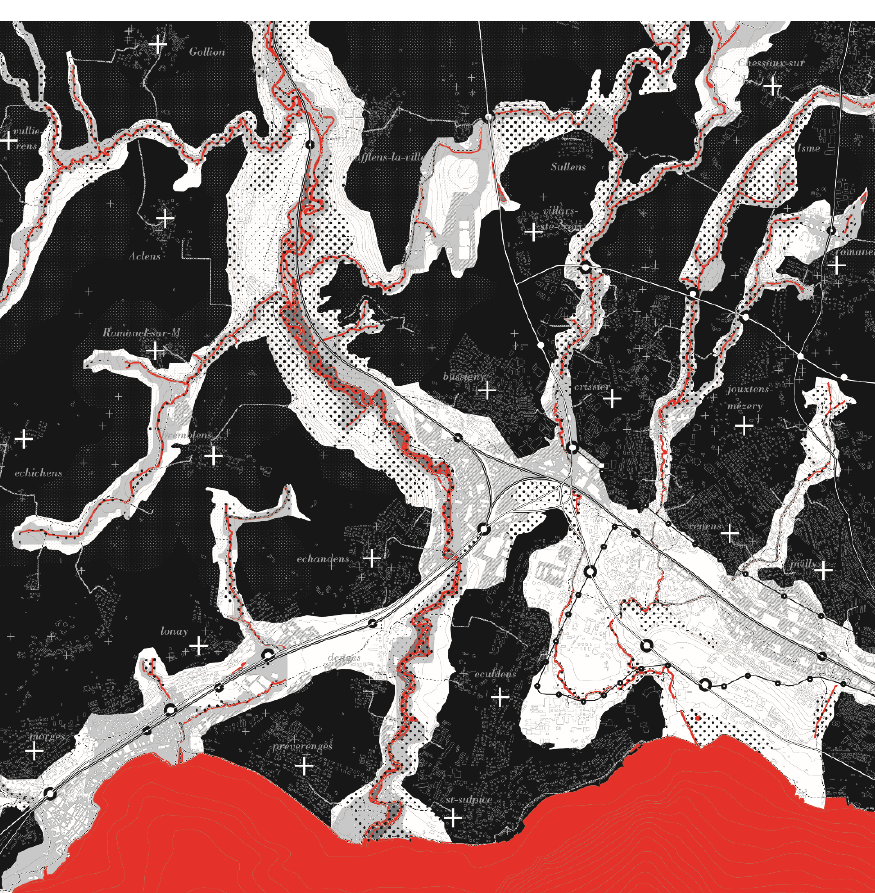
Figure 3. “The espace rivière as territorial park.” West Lausanne Area, 10x10 km: water (red); espace rivière (white); room for water (grey); forest (dotted black); productive and logistic plots (lines hatch); agriculture (dotted white); rail- ways, tramways and bus transportation system (line and black lines); villages (white crosses); built (light grey outlined). Source: EPFL Superstudio Students, fall 2014 and Horizontal Metropolis, a radical project , Venice Architecture Biennale 2016,